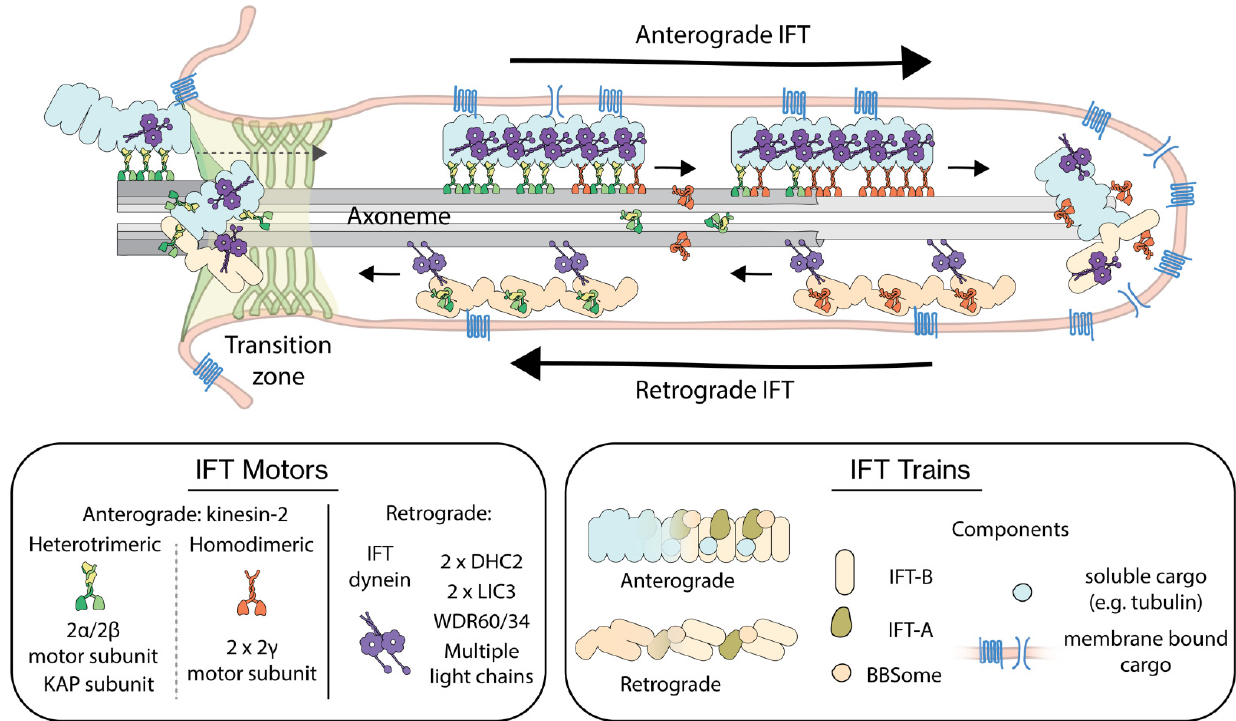
Figure 1. Illustration of intraflagellar transport (IFT) in primary cilia. Anterograde IFT trains assembled at the ciliary base are transported by kinesin-2 motors into the cilium, importing cargo proteins hitchhiking on the trains. At the ciliary tip, anterograde trains are converted to retrograde trains, which are driven back by IFT-dynein motors to the base. In the boxes, the composition of the different players of IFT have been highlighted. Heterotrimeric kinesin-2 is composed of two distinct motor subunits (2 α /2 β ) and a non-motor KAP subunit, while homodimeric kinesin-2 is composed of two identical motor subunits (2 γ ). IFT dynein is a multi-protein complex consisting of two heavy chains (DHC2), two light intermediate chains (LIC3), two non-identical intermediate chains (WDR60/34) and several light-chain dimers. IFT trains are built up of three multiprotein-complex subunits, IFT-A, IFT-B and BBSome and carry cytosolic as well as membrane-bound cargo.